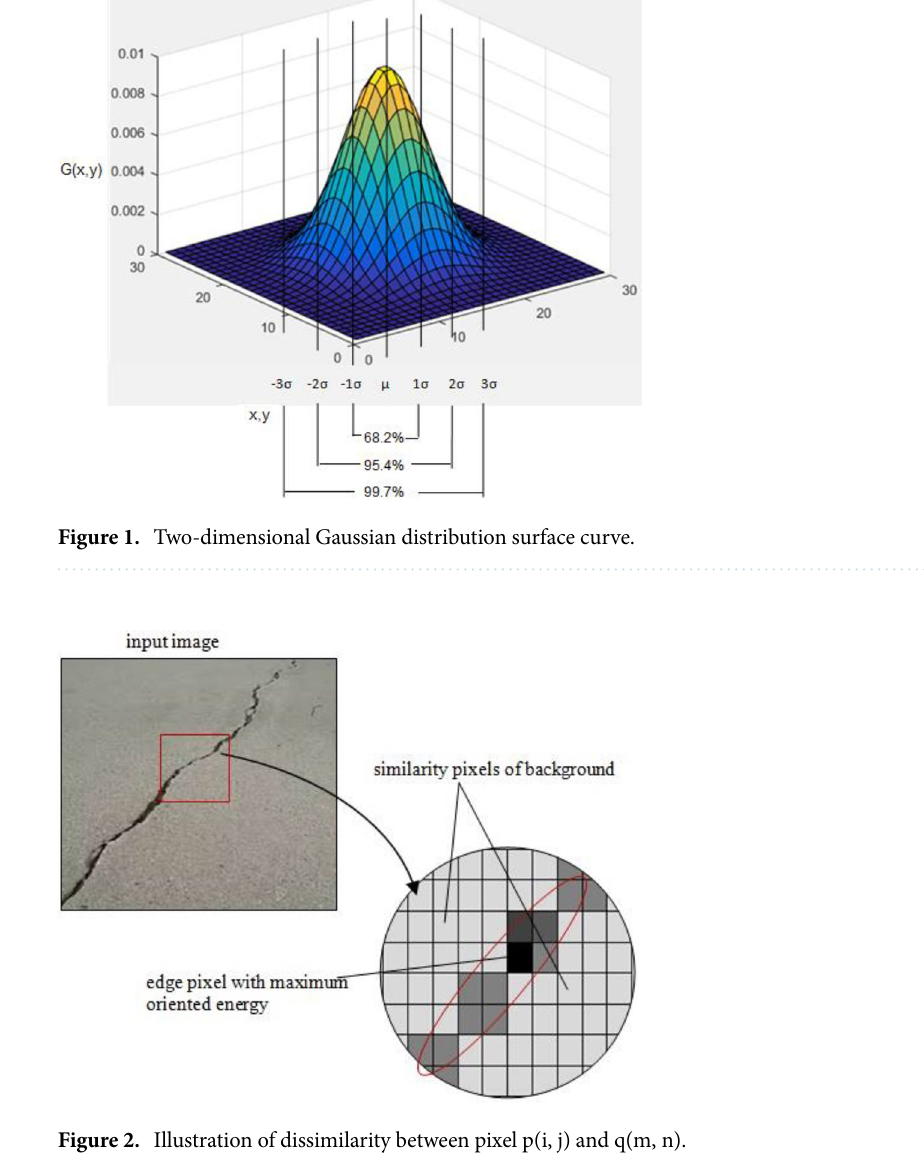
Figure 2. Illustration of dissimilarity between pixel p(i, j) and q(m,